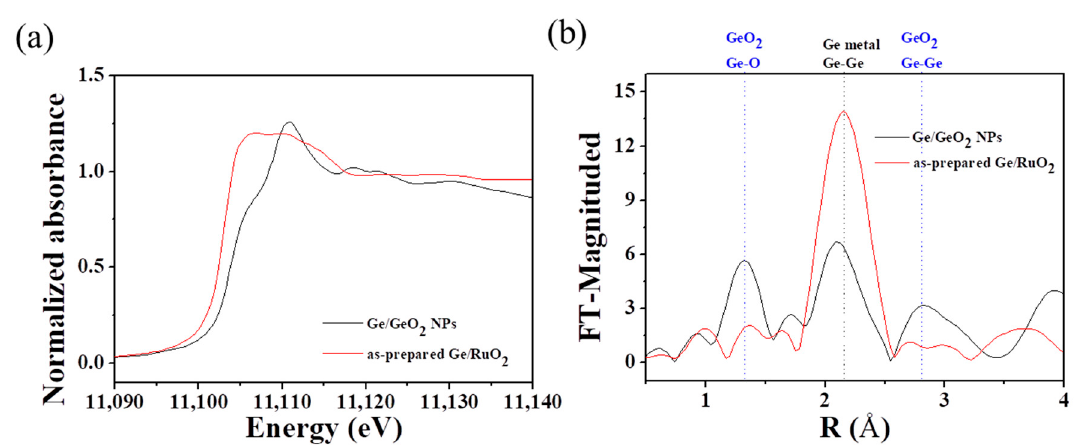
Figure 3. ( a ) Normalized XANES spectra acquired at Ge K-edge and ( b ) Fourier-transform of the EXAFS spectra of Ge/GeO 2 NPs and as-prepared Ge/RuO 2 . EXAFS spectra of Ge/GeO 2 NPs and as-prepared Ge/RuO 2